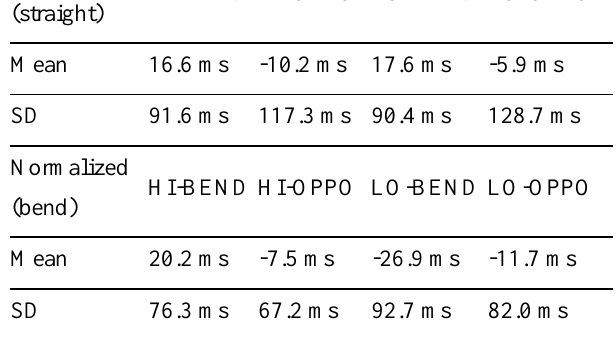
Table 5. Mean reaction time changes and standard devia- tions for the different target locations in straights and on